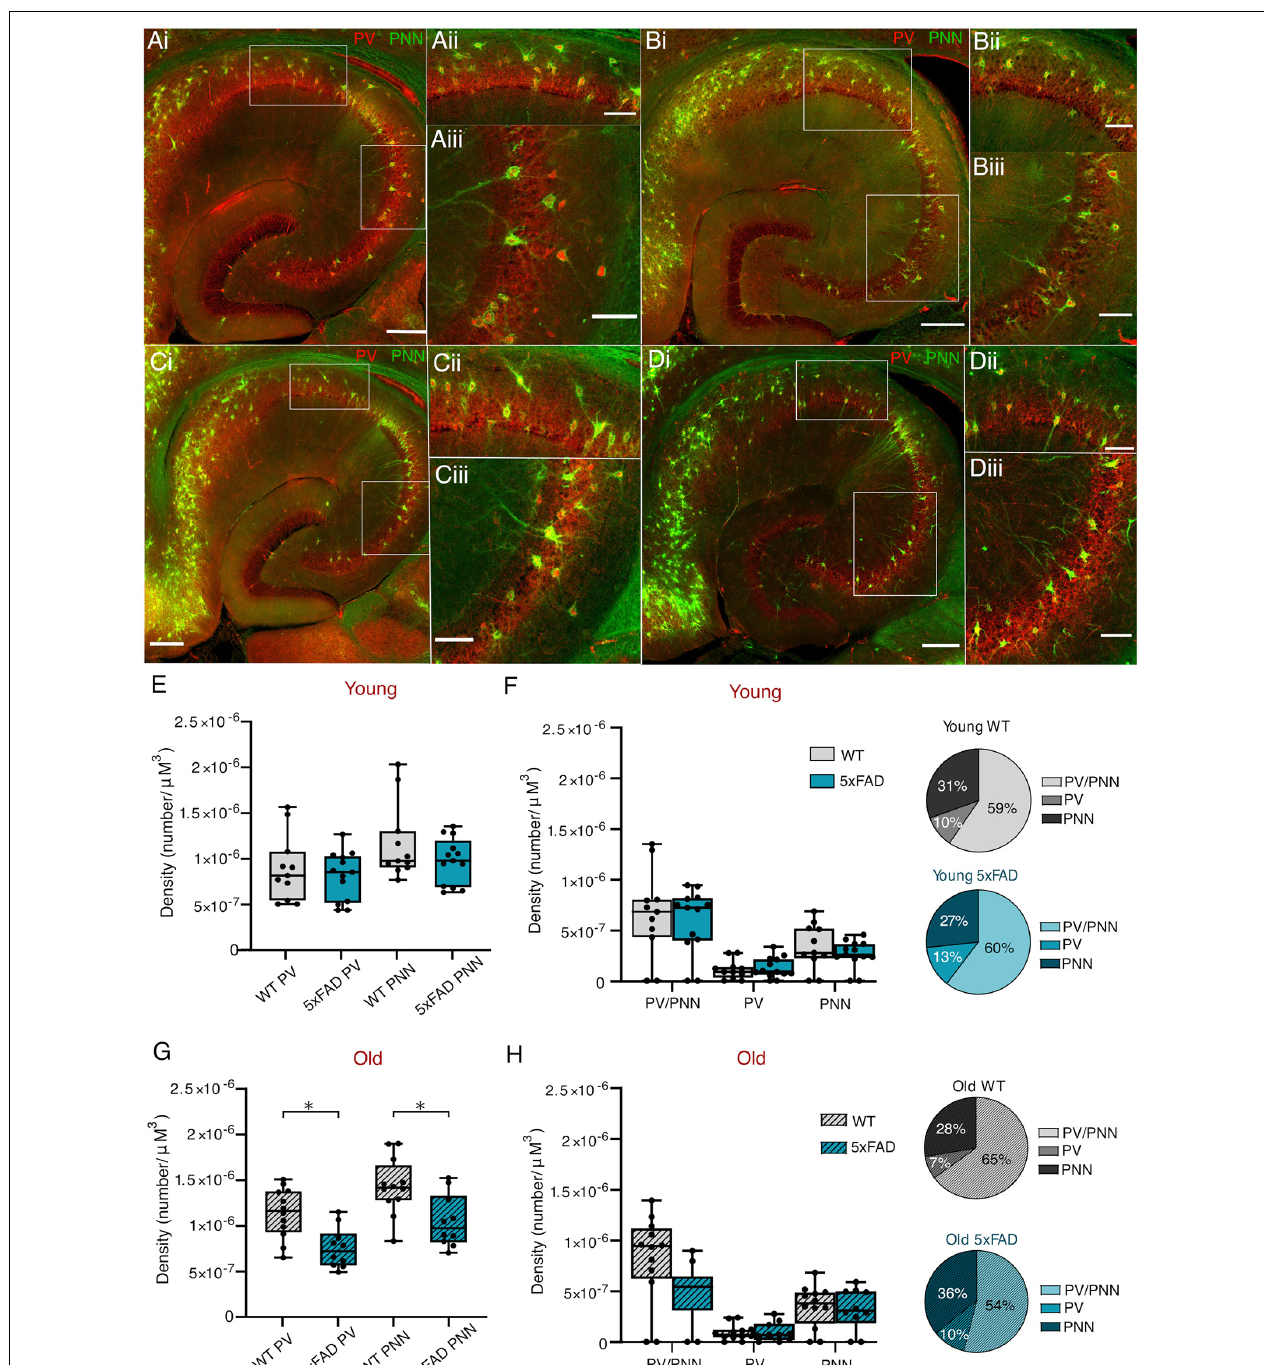
FIGURE 8 | PVIN and PNN densities in young and old 5xFAD and control mice. (Ai–Di) Representative maximum intensity projection images of ventral hippocampal slices processed with anti-PV and biotinylated WFA antibodies to label PV cells (red) and perineuronal nets (PNNs; green), respectively (scale bar = 250 µ m). Young control (A) , Young 5xFAD (B) , Old control (C) , Old 5xFAD (D) . Enlarged images of the CA1 (Aii–Dii) and CA3 (Aiii–Diii) regions highlighted in the boxed region on the main image (Scale bar = 100 µ m). (E,G) Total PV numbers and PNN numbers in young and old slices within CA1 and CA3. (F,H) Combined CA1/CA3 density of PV cells with PNN, PV cells without PNN, and PNN without PV cells in the young and old slices, respectively, with the proportions shown additionally as pie charts. Box plots show the median as the black line, the boxed region indicates the interquartile range, and the whiskers indicate the range. The individual data points represent slices. Young WT: n = 11 slices, four mice (two females); Young 5xFAD : n = 13, three mice (two females); old WT: n = 12 slices, six mice (three females); old 5xFAD : n = 10 slices, six mice (three females). ∗ p < 0.05 (two-way ANOVA with Sˇ idák correction for multiple comparisons).